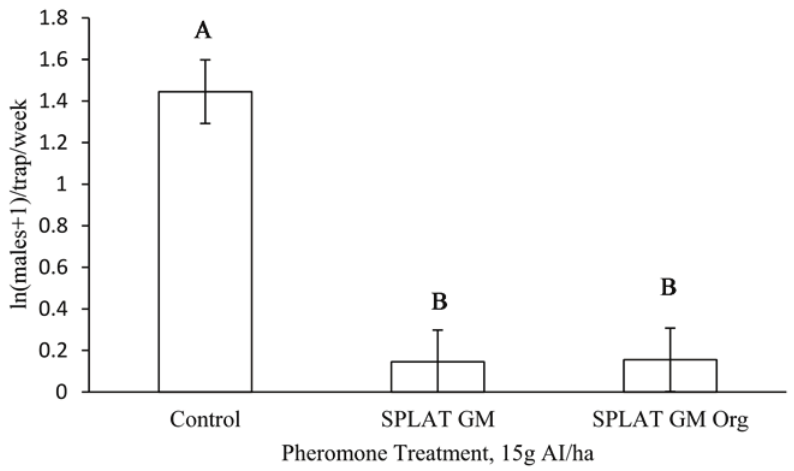
Figure 3. Male moth catches in pheromone-baited traps in Virginia, 2011.